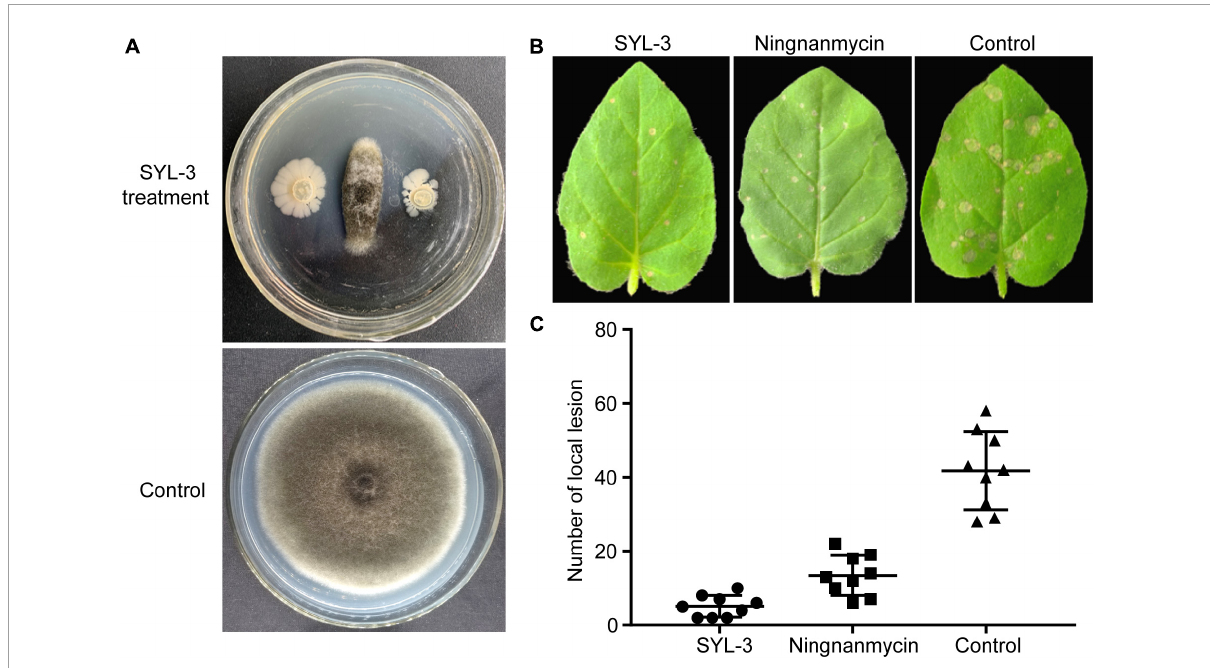
FIGURE3 Antagonistic activities of SYL-3 against A. alternata and TMV. (A) Effects of SYL-3 on the mycelial growth of A. alternata in vitro . (B) Effects of SYL-3 or ningnanmycin on the necrotic lesions caused by TMV on N. glutinosa leaves. (C) Scatter plot of the necrotic lesions on N. glutinosa leaves treated with SYL-3, ningnanmycin, and sterile water (control).